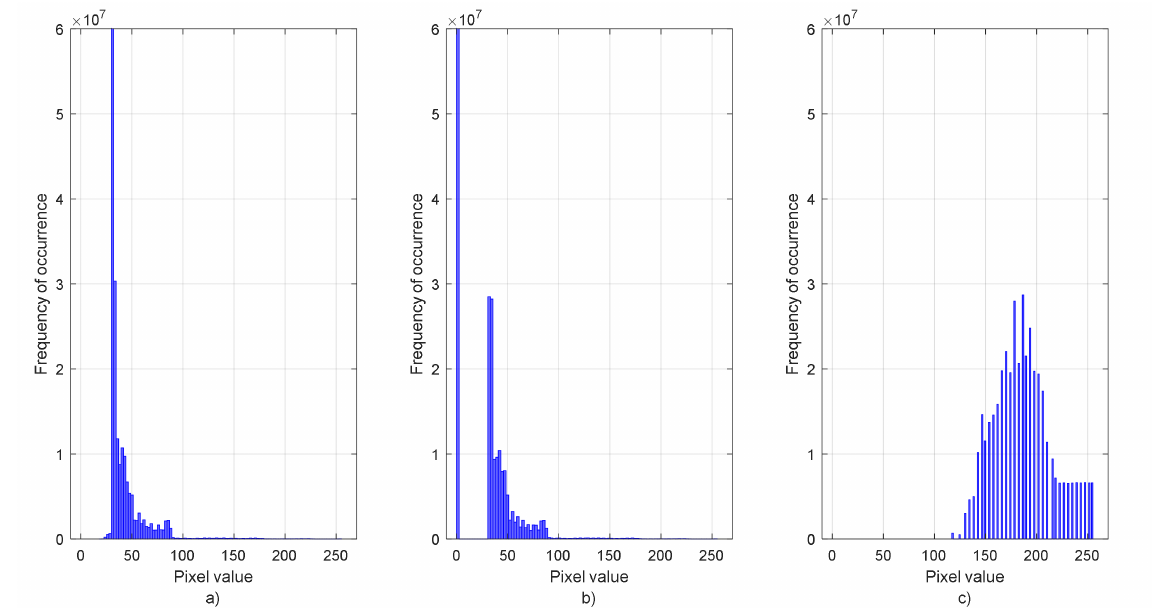
Figure 4. ( a ) Original histogram of grayscale image, ( b ) Histogram with background set to 0, and ( c ) Equalized histogram.